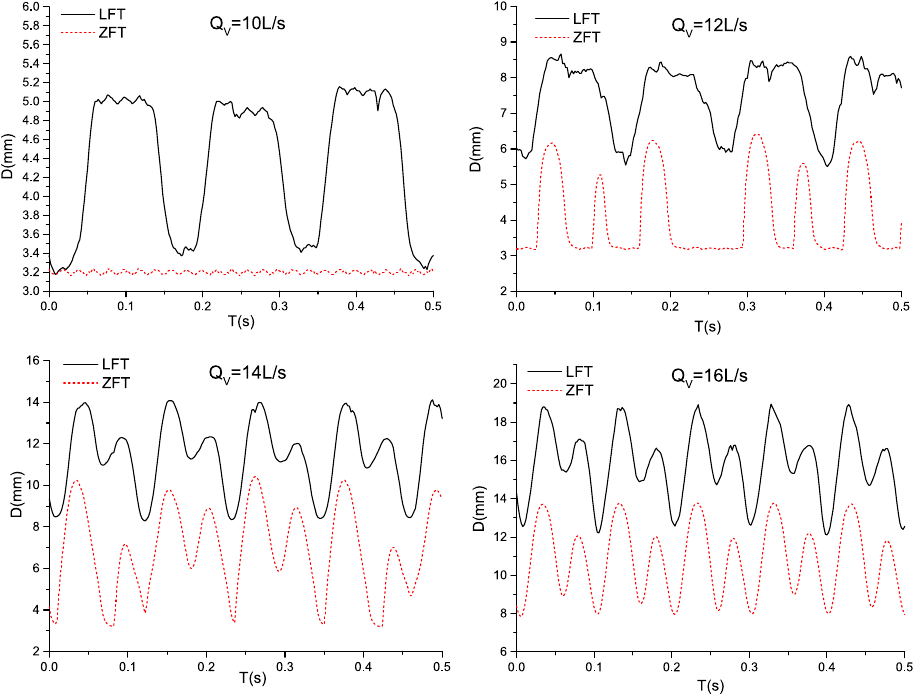
Figure 7. Variation of the measured displacement D with time T for different supply volume flow rates Q V .